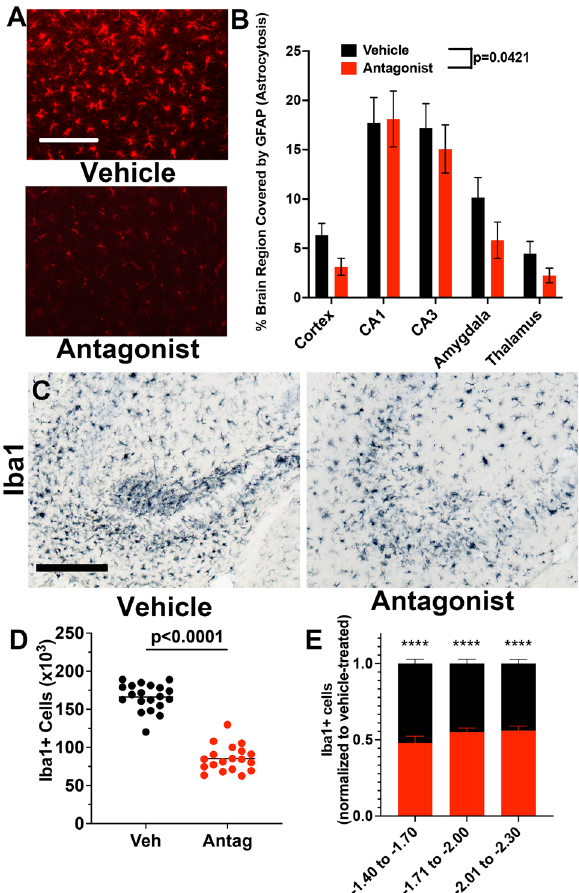
Figure 8. Astrocytosis and microgliosis are dampened in CCR2 antagonist-treated mice. GFAP staining for astrocytes in the amygdala three days after KA SE reveals more gliosis in the vehicle-treated mice ( A ) compared to mice treated with the CCR2 antagonist. Scale bar is 200 μm. Astrocytosis was damped across four out of five brain regions examined in CCR2 antagonist-treated mice ( B , red bars) when compared to vehicle-treated mice (black bars) n = 18–20/group. Paired t-test, p = 0.0421. ( C ) Iba1+ macrophages underwent activation and clustering in both vehicle- and antagonist treated mice. Scale bar is 200 μm. ( D ) Stereological analysis revealed ~ 166,000 Iba1+ cells in the vehicle-treated mice and ~ 85,400 Iba1 + cells in the antagonist-treated mice (unpaired t-test, p < 0.0001). Horizontal bars are at the mean, and each symbol represents data from one mouse. ( E ) Plot of the number of Iba1+ macrophages tabulated and normalized to vehicle-treated controls in the hippocampus segmented across Bregma coordinates. One-way ANOVA followed by Holm-Sidak’s comparisons tests found significant differences between treatments in the three regions examined (**** p < 0.0001 for each